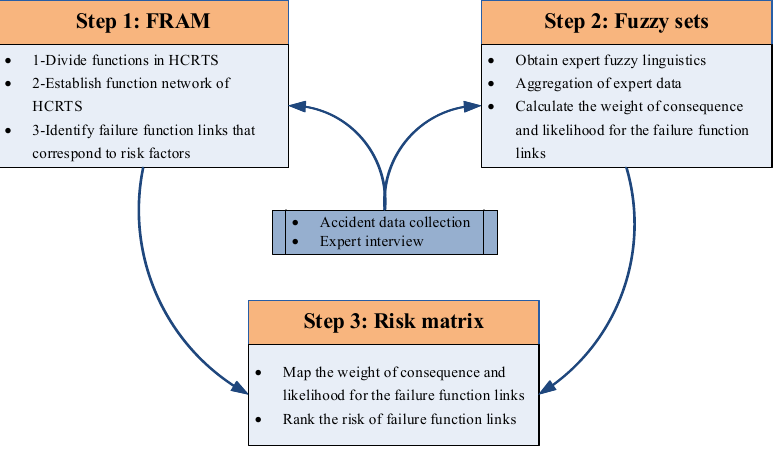
Figure 2. Framework of the proposed